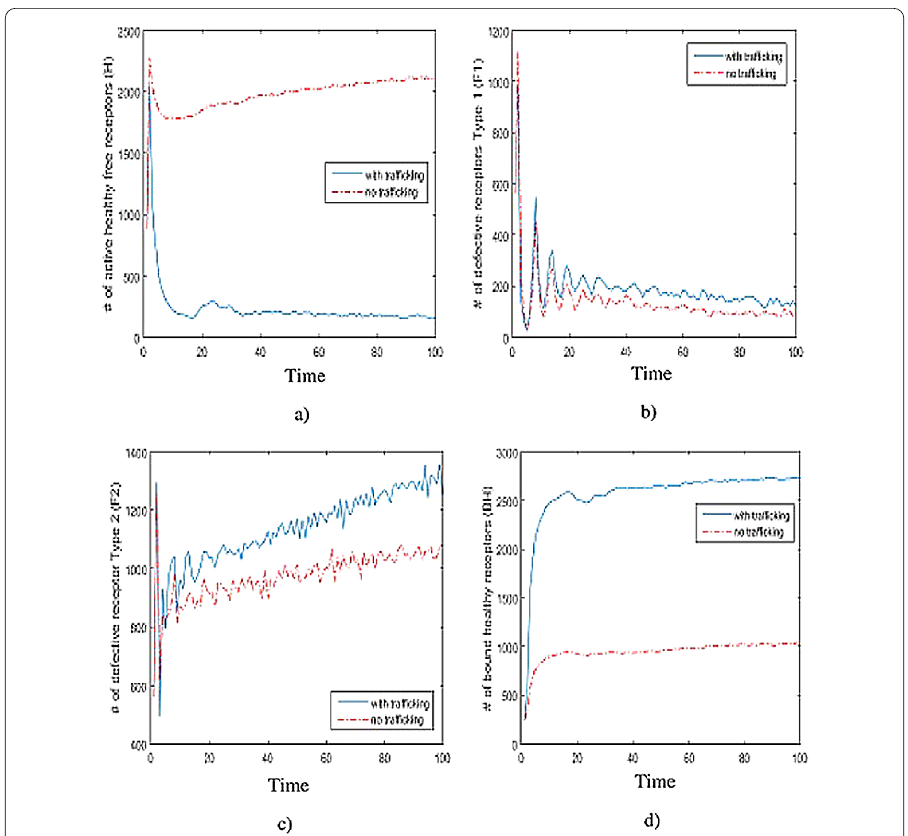
Figure 5 Simulated time courses of the numbers of (a) free healthy receptors, (b) type 1 free defective receptors, (c) type 2 free faulty receptors, and (d) bound healthy